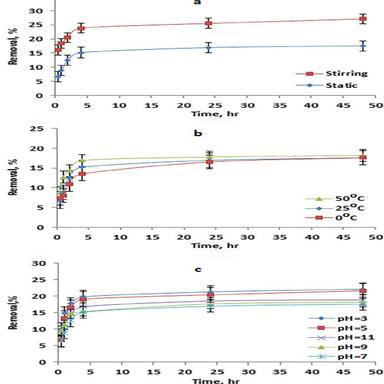
Removal of 137Cs from spiked water using titanate nanofibers at different variables.